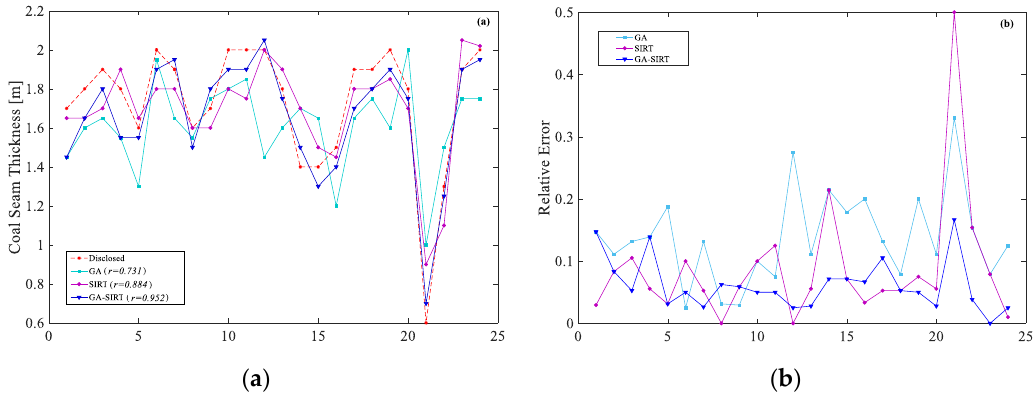
Figure 7. The correlation coefficient results ( a ) and the relative error results ( b ) of coal thickness between disclosed and calculated by GA, SIRT, and the hybrid algorithm (GA-SIRT) respectively.